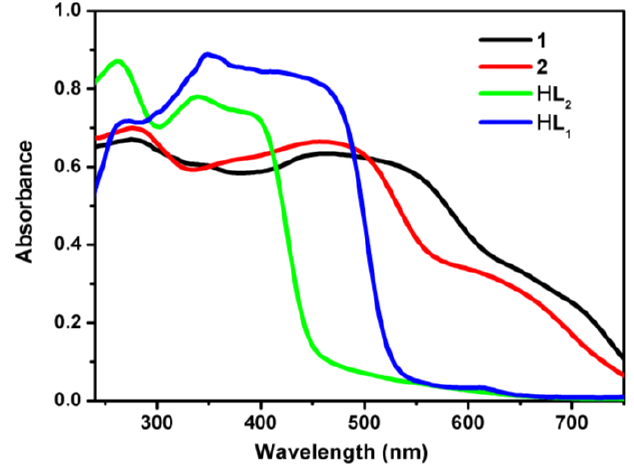
Figure 11. UV-Visible absorption of H L 1 , H L 2 , 1 , and 2 in solid state.